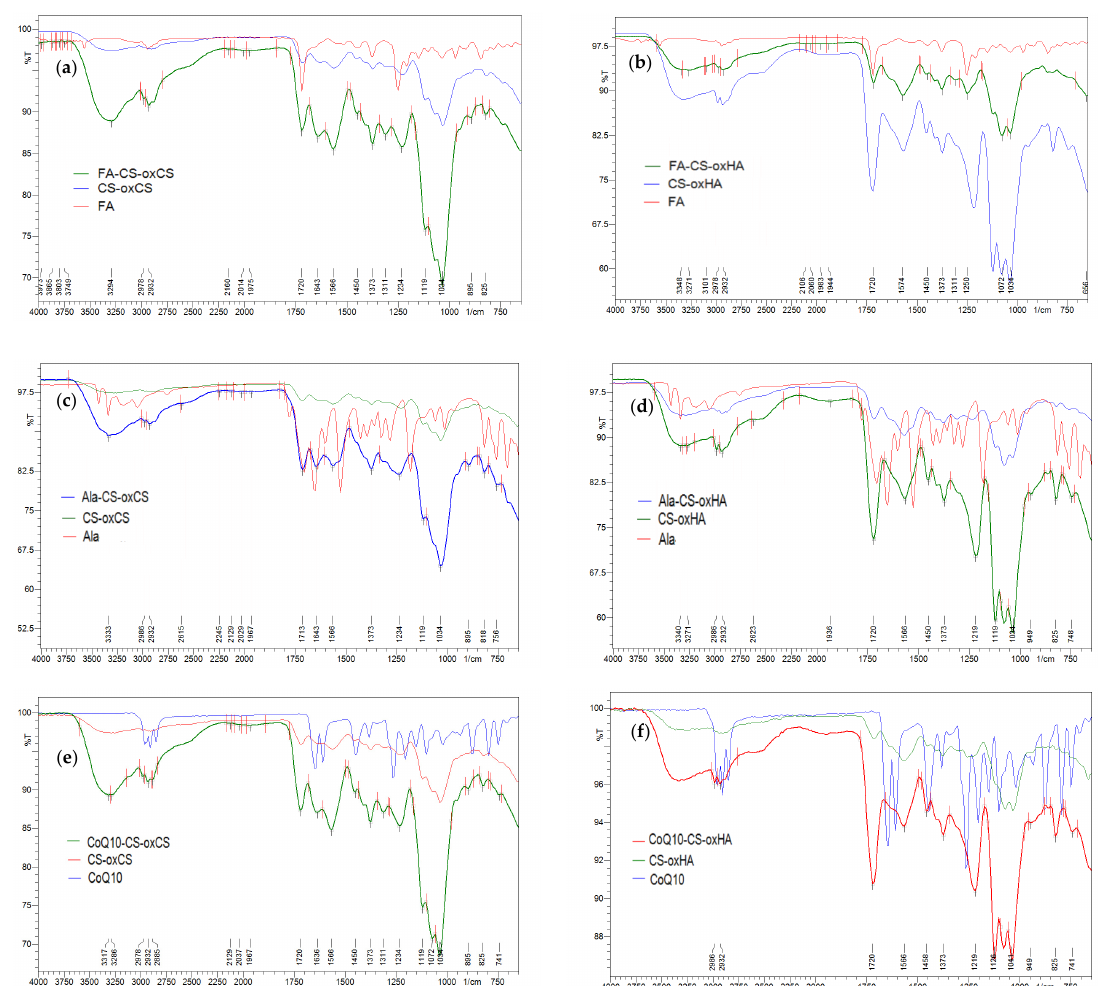
Figure 7. FT-IR spectra of API-CS-oxCS/oxHA hydrogels: ( a ) FA-CS-oxCS vs. CS-oxCS and FA; ( b ) FA-CS-oxHA vs. CS-oxHA and FA; ( c ) Ala-CS-oxCS vs. CS-oxCS and Ala; ( d ) Ala-CS-oxHA vs. CS-oxHA and Ala; ( e ) CoQ10-CS-oxCS vs. CS-oxCS and CoQ10: ( f ) CoQ10-CS-oxHA vs. CS-oxHA and CoQ10.